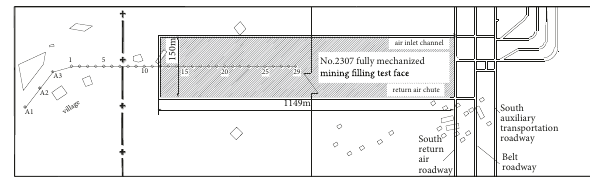
Figure 2: No. 2307 fully mechanized backfill mining face and surface movement deformation observation point.